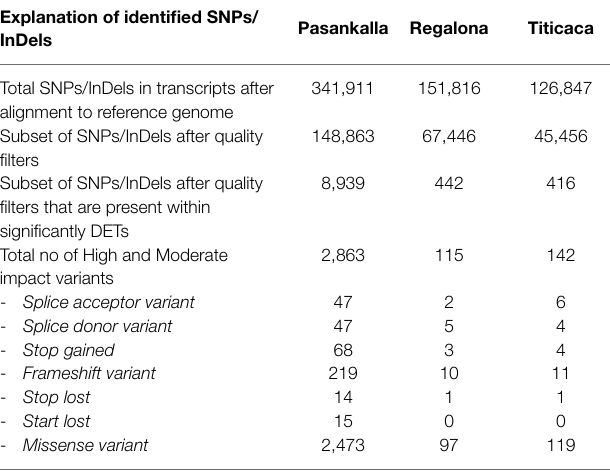
TABLE 2 | Number of sequence variations (SNPs/InDels) in quinoa seed transcriptomes as compared to the quinoa reference genome. Explanation of identified SNPs/